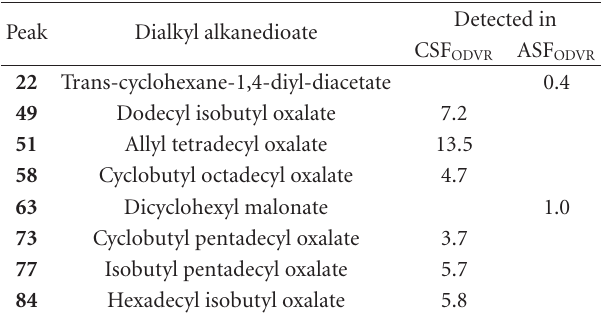
Table 4: Dialkyl alkanedioates in the products from CSF ODVR and ASF ODVR .